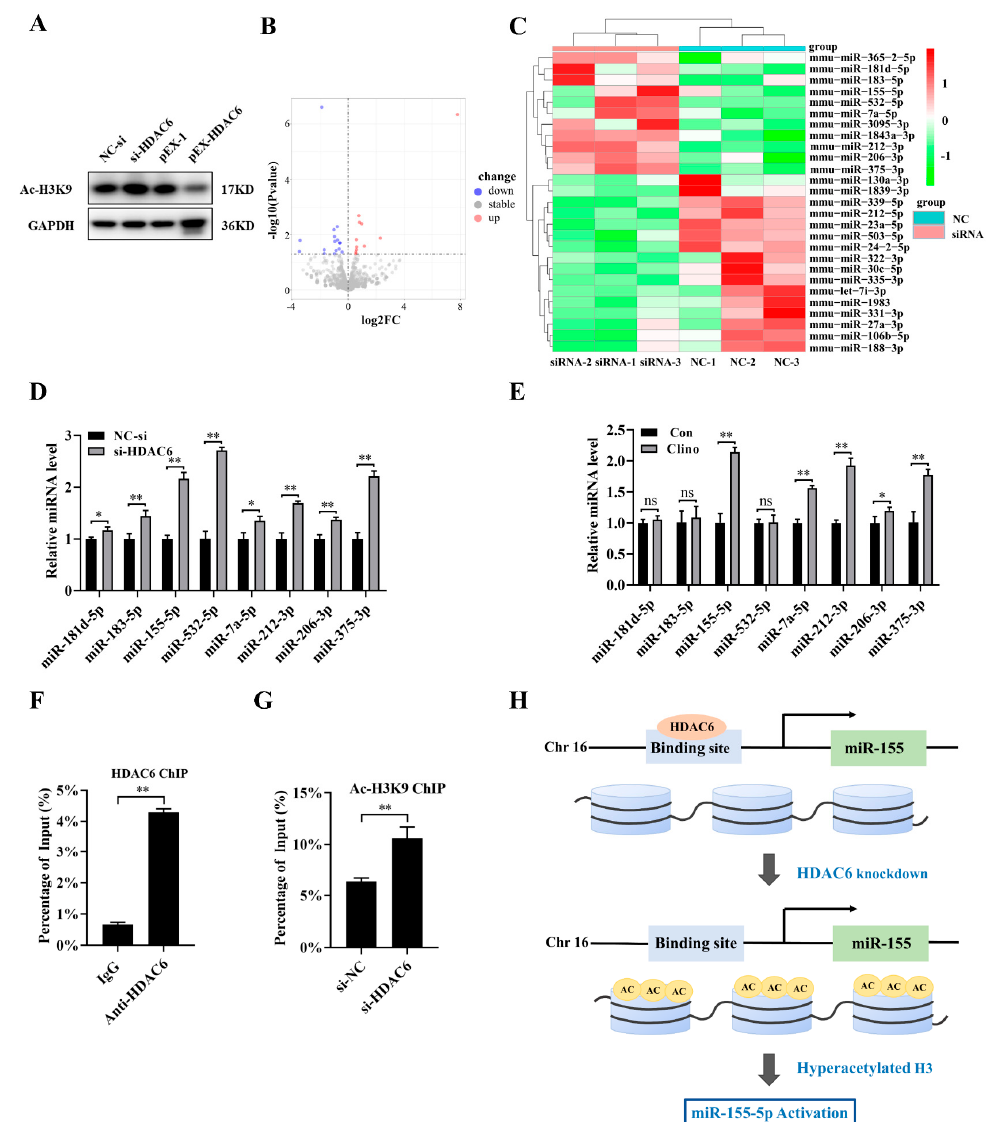
Figure 3. HDAC6 inhibition increases intranuclear histone expression and increases in miR-155-5p expression in microvascular endothelial cells. ( A ) Ac-H3K9 protein expression was analyzed by Western blotting in microvascular endothelial cells treated with HDAC6 siRNA, pEX-HDAC6 or the corresponding controls for 48 h (N = 3). ( B ) Representative volcano plot of miRNA expression levels after HDAC6 siRNA-transfected microvascular endothelial cells based on the RNA-seq results. ( C ) Representative heatmap of miRNA expression levels after HDAC6 siRNA transfection of microvascular endothelial cells based on the RNA-seq results (N = 3). ( D ) Differential miRNA expression analysis of HDAC6 siRNA-transfected microvascular endothelial cells was verified by qRT-PCR (N = 3). ( E ) The differential expression of miRNAs selected from microarray assay data was determined by qRT-PCR in microvascular endothelial cells under clinorotation-unloading conditions for 48 h (N = 3). ( F ) ChIP-qRT-PCR assay to assess HDAC6 association with the miR-155-5p promoter (N = 3). ( G ) ChIP-qRT-PCR assay to assess the enrichment of histone deacetylation by HDAC6 in the miR-155-5p promoter region (N = 3). ( H ) Schematic diagram of HDAC6, the mechanism which regulates miR-155-5p expression through the deacetylation of histones in the miR-155 promoter. * p < 0.05, ** p < 0.01 vs.